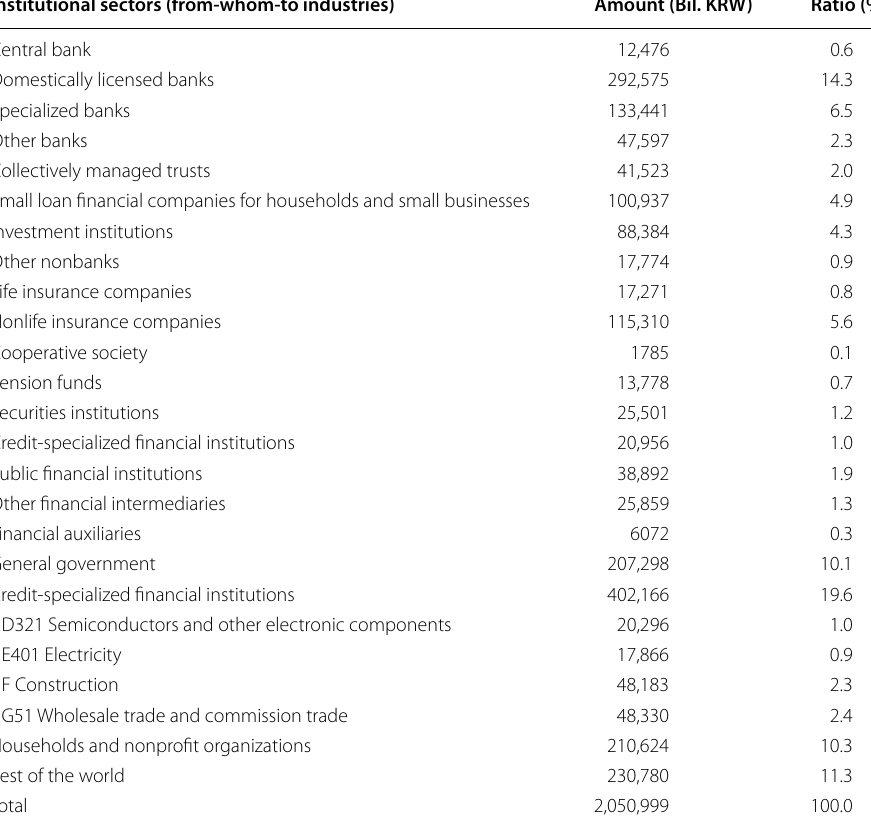
Table 9 Fund-raising portfolio of total industries in 2005 Institutional sectors (from‑whom‑to industries) Amount (Bil.